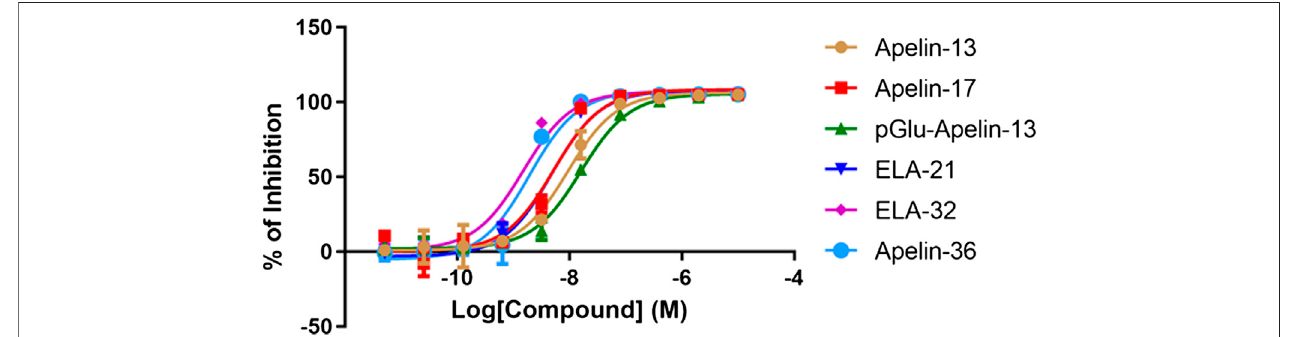
FIGURE 2 | Radio-ligand competition results of the six peptides with [ 125 I]-apelin-13. All data points were in triplicates and the standard errors were displayed in error bars. The inhibition rates have been normalized to Apelin-13.